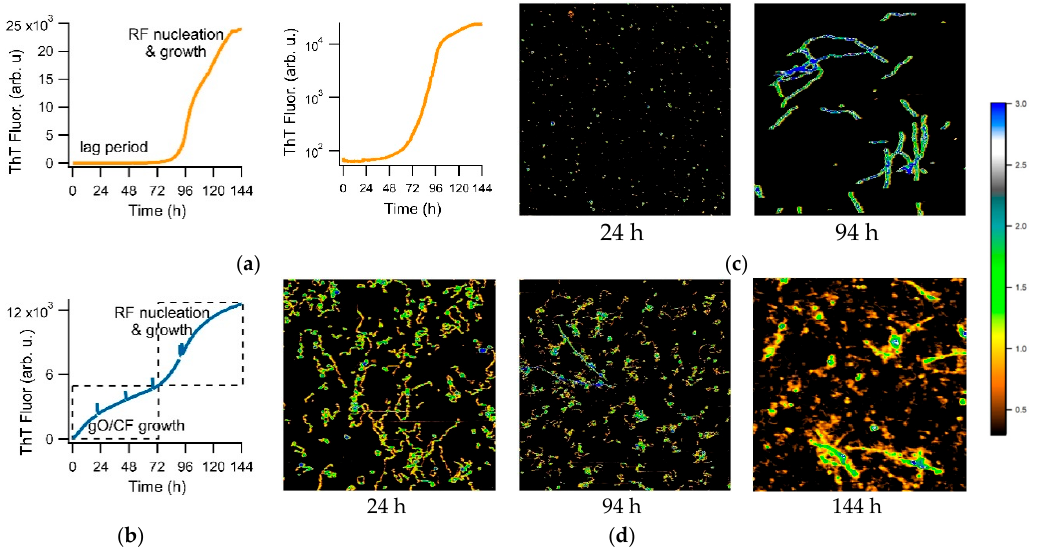
Figure 1. Sigmoidal versus biphasic amyloid kinetics and corresponding aggregate morphologies. Amyloid growth kinetics of hen egg-white lysozyme (hewL), recorded with thioflavin T (ThT), displaying either ( a ) sigmoidal (21 μ M hewL) or ( b ) biphasic (350 μ M hewL) growth kinetics (pH 2, 52 °C, 400 mM NaCl). Second panel in ( a ) is the same data on a semi-log scale to highlight the flat baseline. Spikes in the traces mark the times when aliquots were collected for imaging. Atomic force microscopy (AFM) images of the aggregate morphologies observed during ( c ) sigmoidal versus ( d ) biphasic growth of hewL, at the indicated time points. False color height scale: 3 nm.